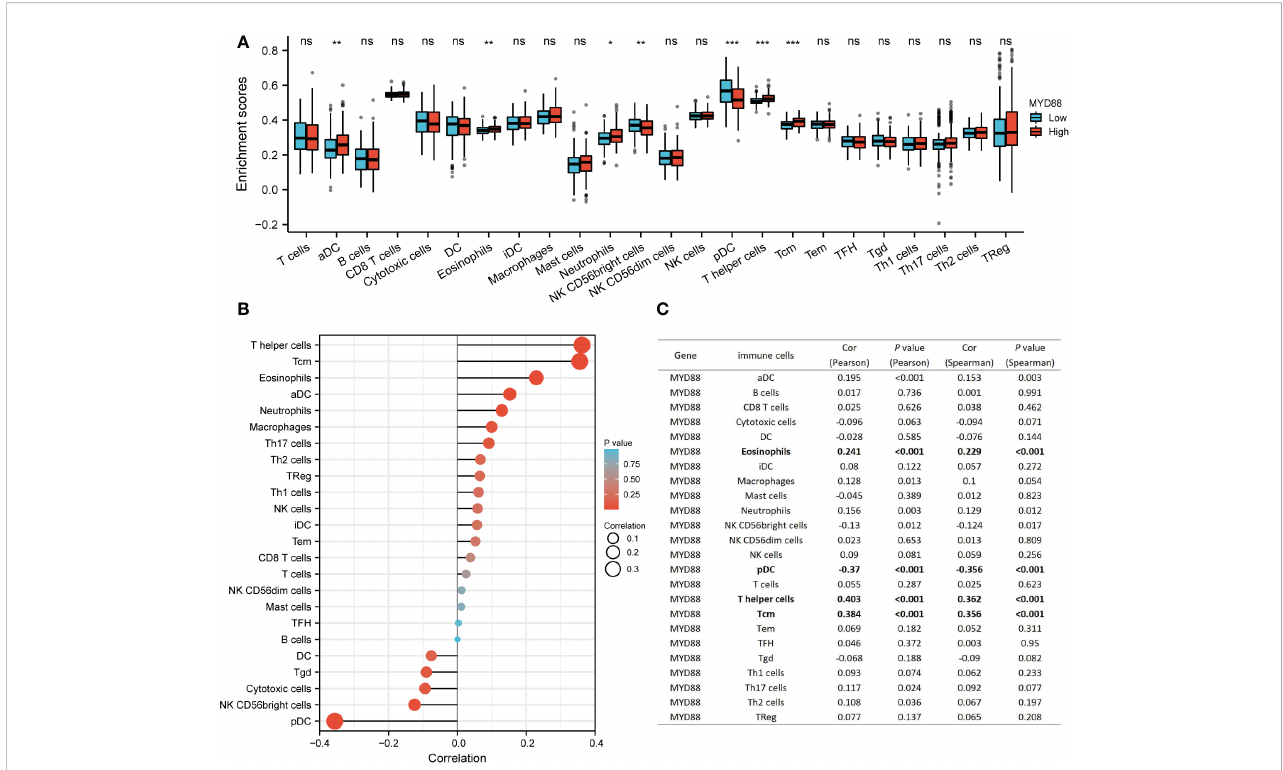
FIGURE 4 The relationship between MyD88 and immune cells. (A) The differential in fi ltration level of immune cells between the high MyD88 group and the low MyD88 group. * P < 0.05, ** P < 0.01, *** P < 0.01. (B, C) The Spearman correlation analysis between MyD88 and immune cells was estimated through the ssGSEA algorithm. Myd88, Myeloid differentiation primary response protein 88; ssGSEA, Single sample gene set enrichment analysis; DC, dendritic cells; NK, natural